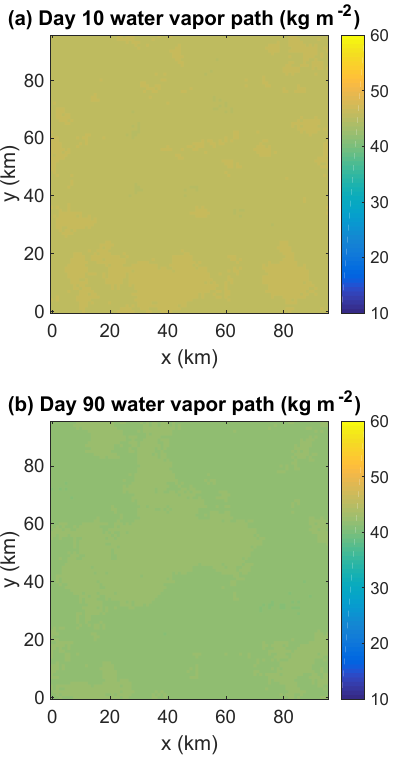
Figure 6. Daily mean water vapor path (computed from hourly av- erages) on day 10 (a) and day 90 (b) of the small-domain SAM simulation at T s = 300K.